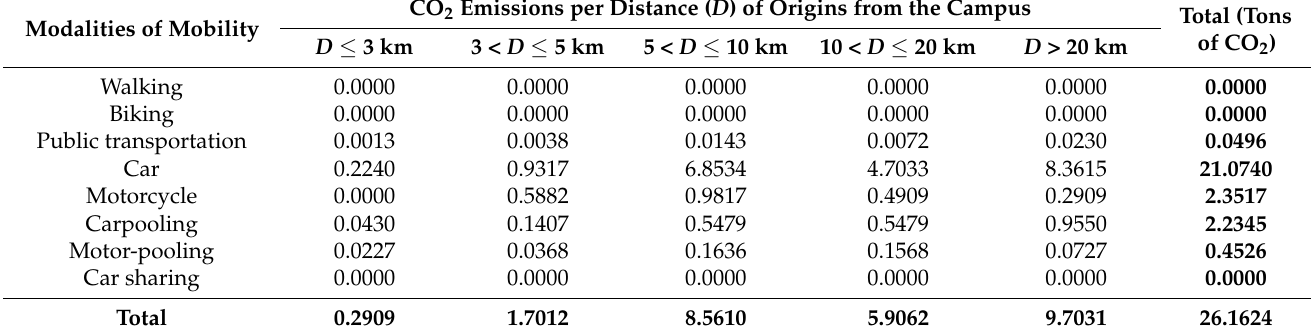
Table 3. SCENARIO 0 —daily CO 2 emissions per zone and mobility modality and per vehicle occupation for all commuters, E zm (tons of CO 2 ).